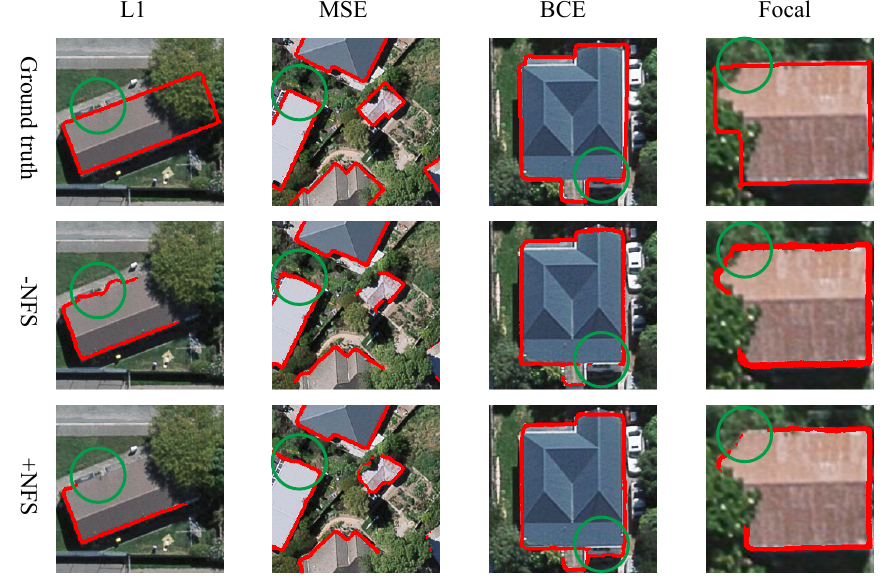
Figure 13. Representative failure cases of outlines extracted from model trained by four losses with/without nearest feature selector (NFS). Backgrounds, red lines, and green circles represent aerial input, predicted outline, and focused area,